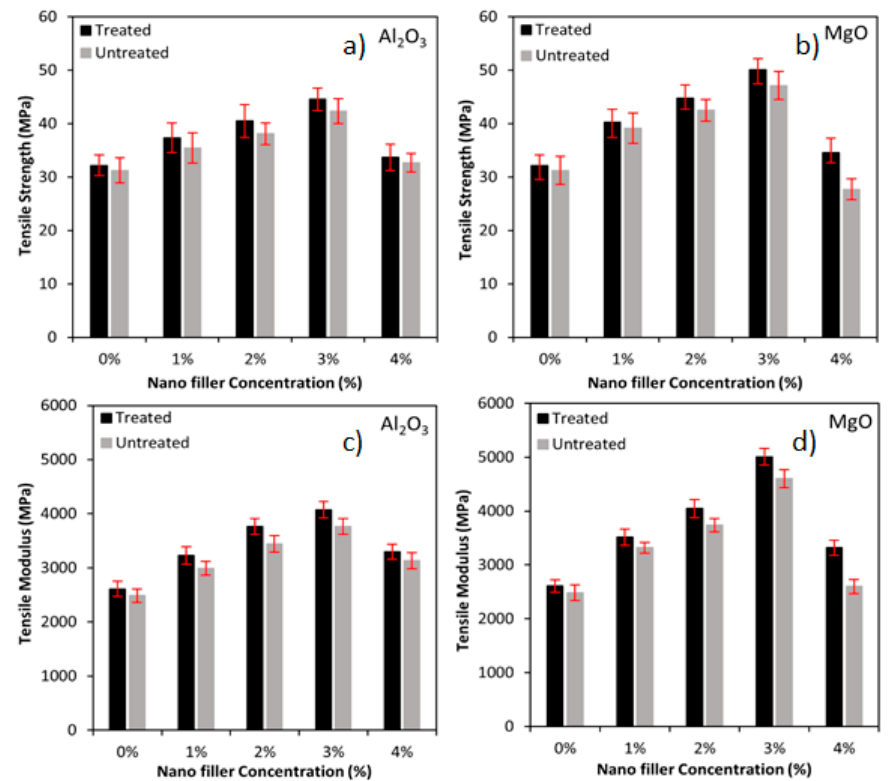
Figure 1. ( a ) Tensile strength of nano Al2O3, ( b ) Tensile strength of MgO, ( c ) Tensile modulus of nano Al2O3, ( d ) Tensile modulus of MgO incorporated flax/PLA epoxy hybrid composites. nano Al2O3, ( d ) Tensile modulus of MgO incorporated flax/PLA epoxy hybrid